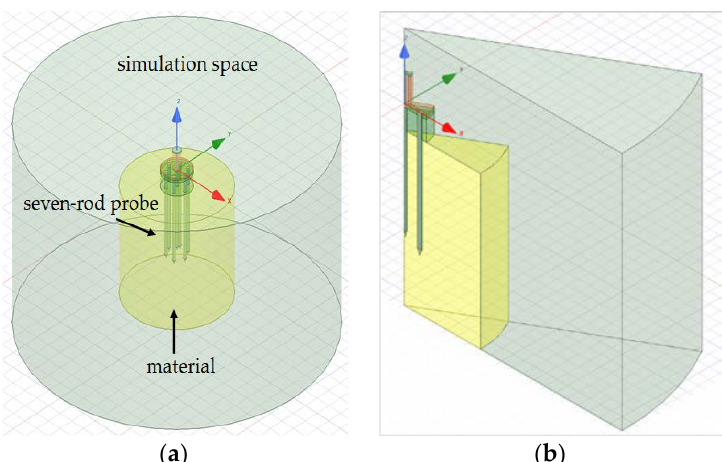
Figure 2. The model of ( a ) the whole simulation space; ( b ) 30 degree sector cut from the whole simulation space consisting of a signal rod and ground ones (dimensions in mm).